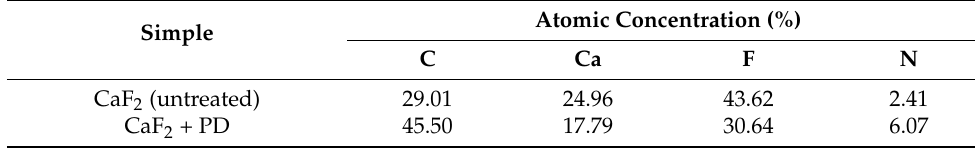
Figure 9. ( a ) Survey and high-resolution ( b ) Ca2p and ( c ) F1s XPS spectra recorded for fluorite pre- and post-PD processing. Table 2. Elemental composition of CaF 2 with and without PD on its